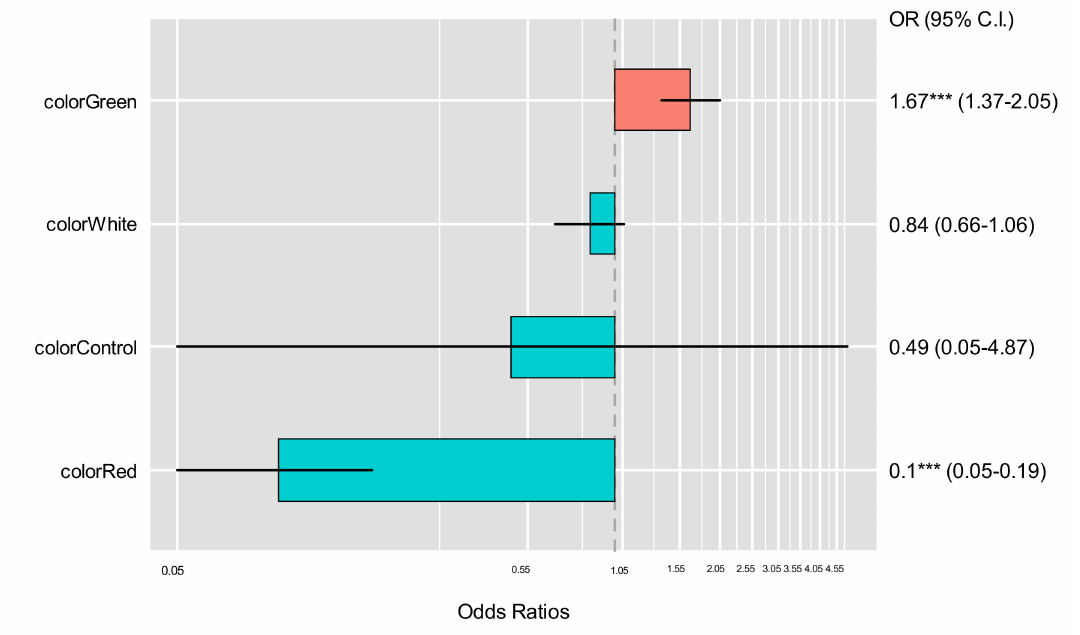
Figure 6. Odds ratios plot for GLMM pot treatment comparison. *** shows significancy of p